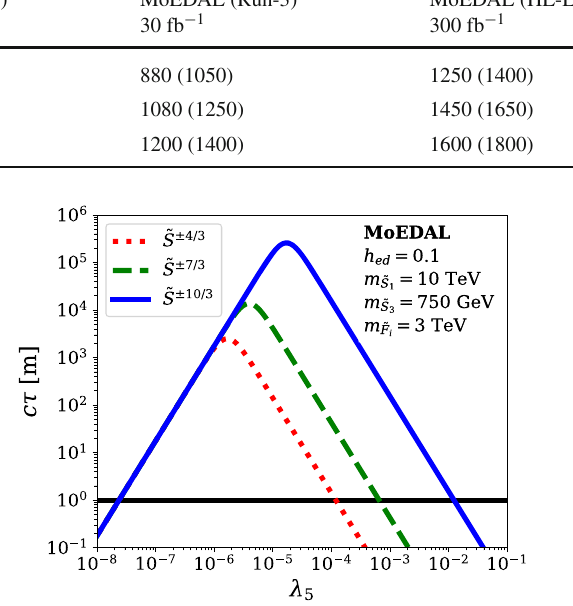
Fig. 10 Lifetimesofmulti-chargedparticles, ˜ S ± 10 / 3 (bluesolid) ˜ S ± 7 / 3 (green dashed) and ˜ S ± 4 / 3 (red dotted), in Model-2 as functions of λ 5 , where h F and h ¯ are fitted to the neutrino data. The m ˜ F